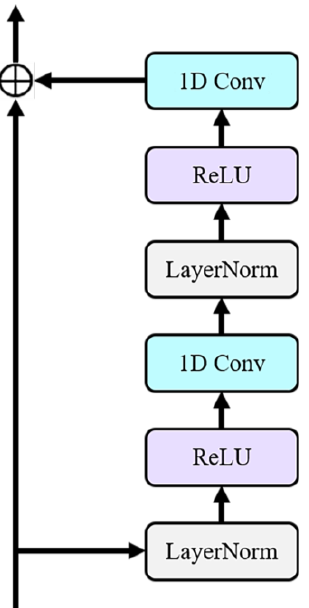
Figure 3. Diagram of the residual unit.